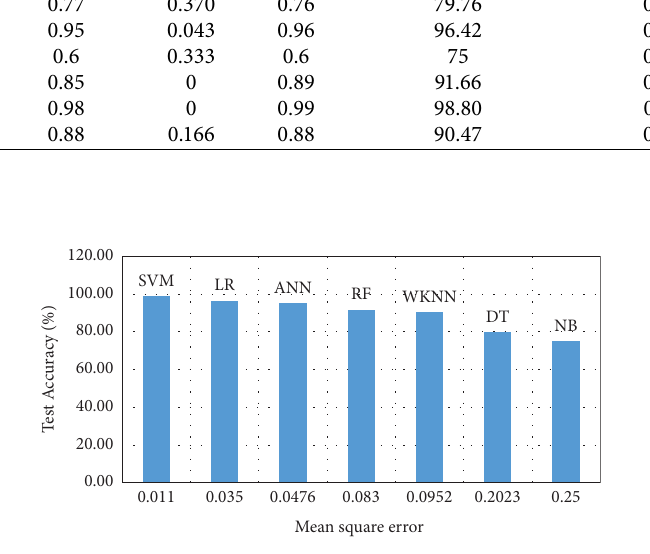
Figure 16: Depicting the test accuracy of images by seven machine learning classifers with a mean square error.